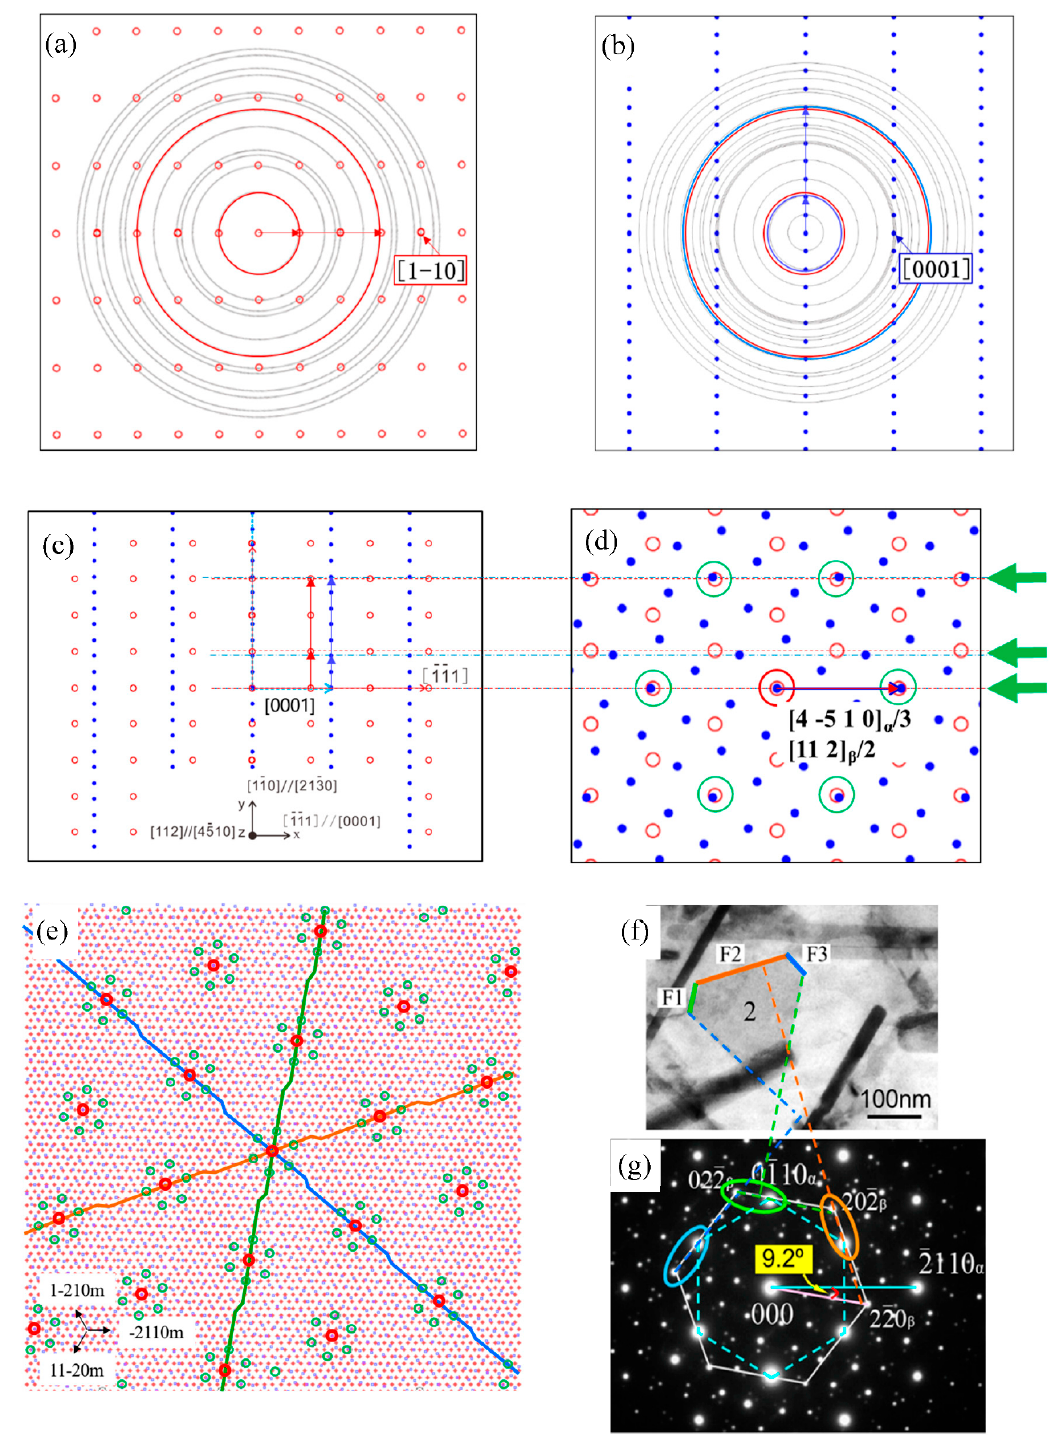
Figure 3. Application of near-row-matching method to a preferred interface between Mg 2 Sn precipitate and Mg matrix: ( a ) rows of lattice points projected along [1 1 2] β ; ( b ) rows of lattice points projected along [4 ⎯ 5 1 0] α , nearly overlapped blue and red circles showing that the nearly row-matching condition is satisfied; ( c ) alignment of near-matching rows to define a potential good-matching interface; ( d ) a GMS cluster around the origin, with near-matching rows indicated by thick arrows; ( e ) periodic GMS clusters, showing a shift of a row between the center of the adjacent clusters; ( f ) morphology of the Mg 2 Sn plate; ( g ) diffraction pattern corresponding to truncated triangular plate in ( f ). See text for more details.